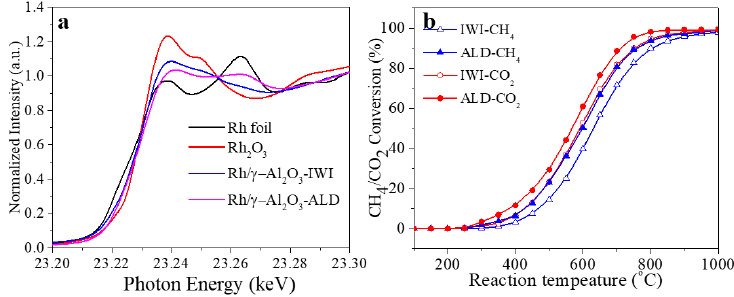
Figure 6. ( a ) Rh K-edge XANES spectra for Rh foil, Rh 2 O 3 , Rh/ γ -Al 2 O 3 catalysts; ( b ) CH 4 and CO 2 conversion of Rh/ γ -Al 2 O 3 catalysts from IWI and ALD between 100–1000 °C.